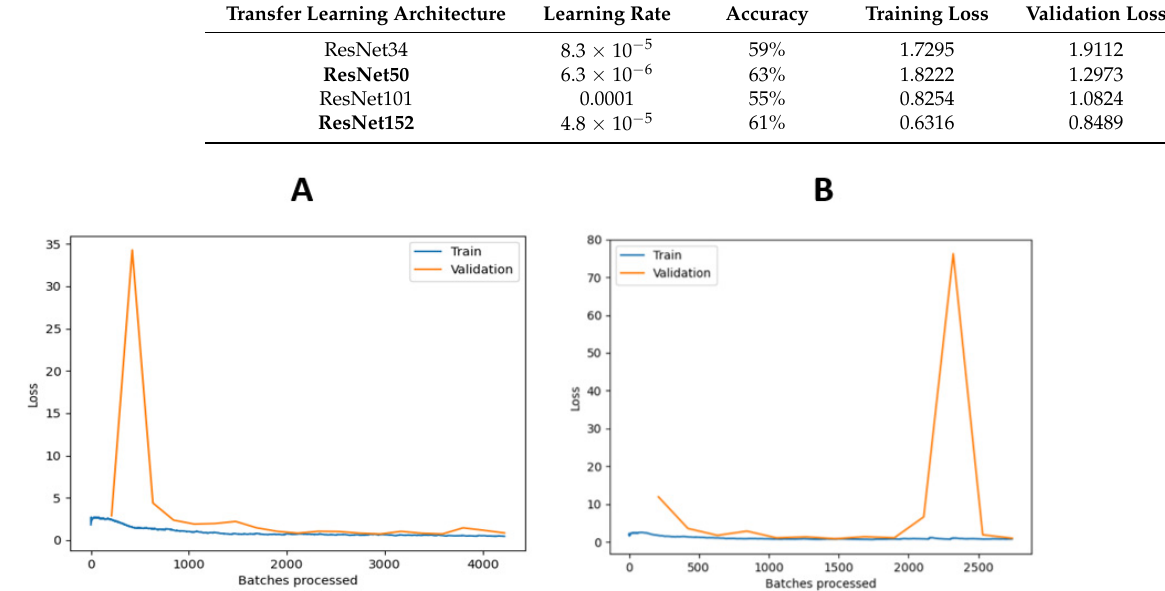
Figure 6. Loss values for the RetinaNet model using the ( A ) ResNet50 backbone and ( B ) ResNet152